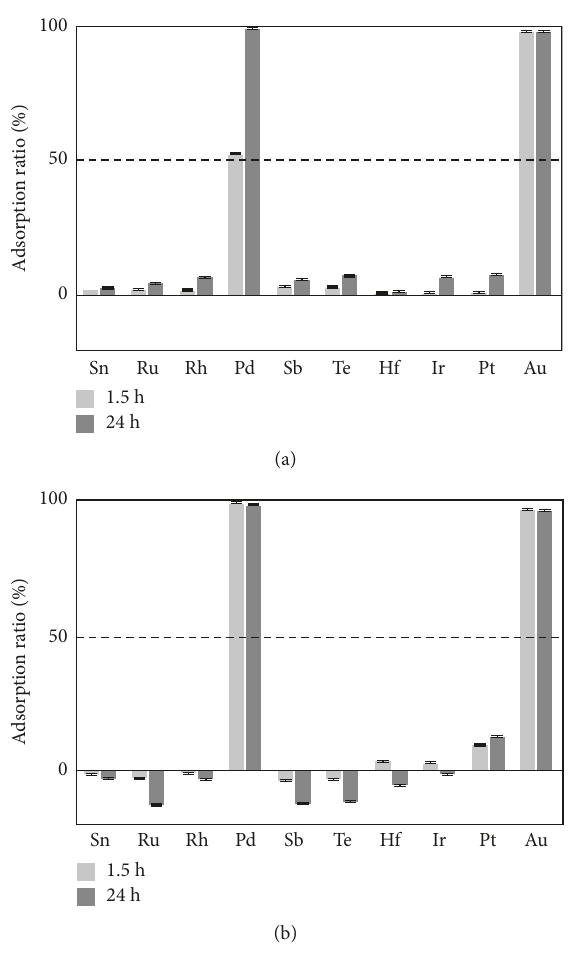
Figure 2: Metal adsorption from multielement solution A with hydrophilic sulfur-containing adsorbents 1 (a) and 2 (b) (feed molar ratio of [C S]/[total metal] 4.5/1). (cid:31) (cid:31)